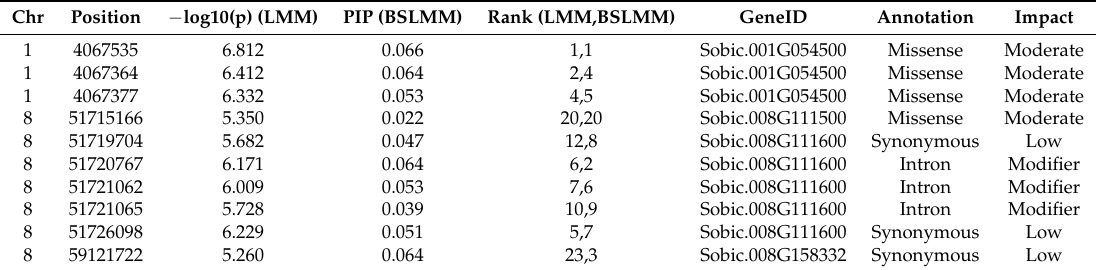
Figure 1. Superimposed Manhattan plot for genome-wide association using a linear mixed model (LMM) and a Bayesian sparse linear mixed model (BSLMM): the chromosome numbers and respective positions of the SNPs are shown on the x-axis. The left y-axis label shows negative log 10 of p -value from Wald’s test for linear mixed model, and the right y-axis label shows the posterior inclusion probability (PIP) for the BSLMM model. The gray dashed line represents the Bonferroni-corrected significance threshold for α = 0.05, and the black dashed line represents a PIP threshold of 0.03. Table 1. Variants from associated regions, their substitution effect, and association statistics. Chr: chromosome, LMM: linear mixed model, BSLMM: Bayesian sparse linear mixed model, and PIP: posterior inclusion